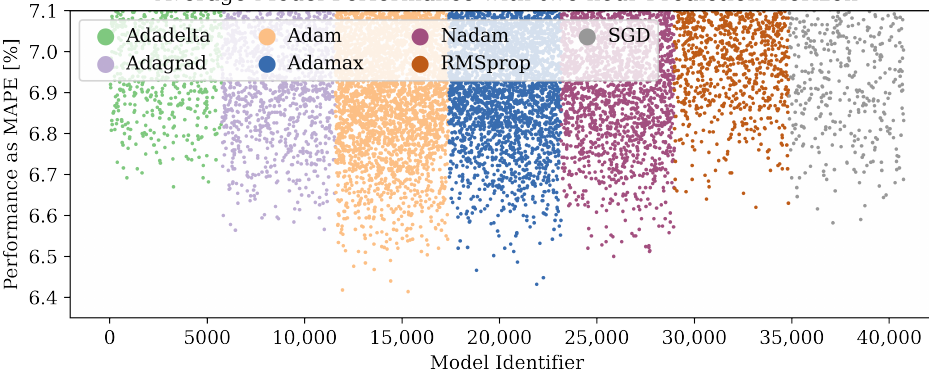
Figure 4. Best performing models with two hour prediction horizon (+2-models) sorted and high- lighted by the optimizer used. Best performing models with Adam (beige) and Adamax (blue) optimizer achieve lower MAPE scores compared to Adadelta (green) or RMSprop